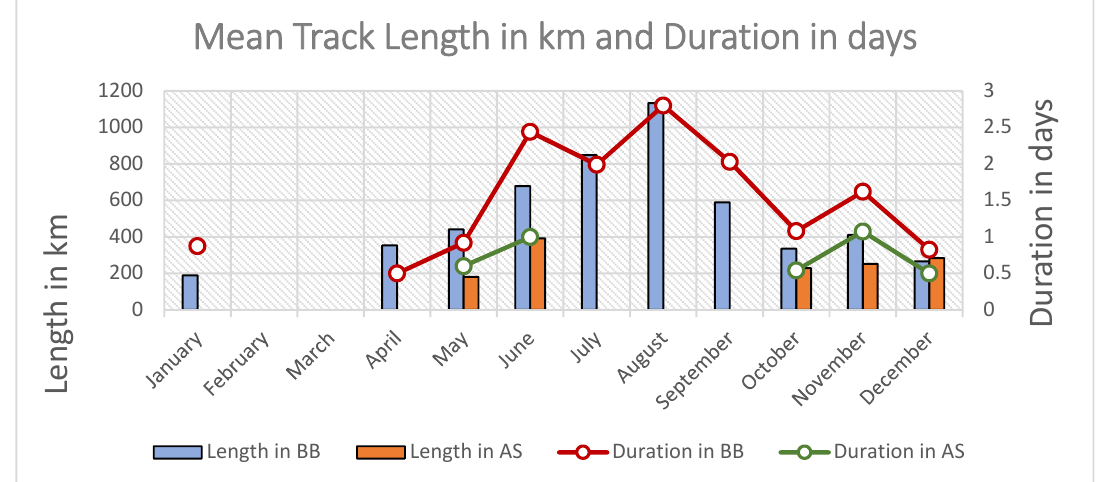
Figure 12. Monthly variation of TC over land mean track length and duration for the Bay of Bengal (BB) and the Arabian Sea (AS) region.